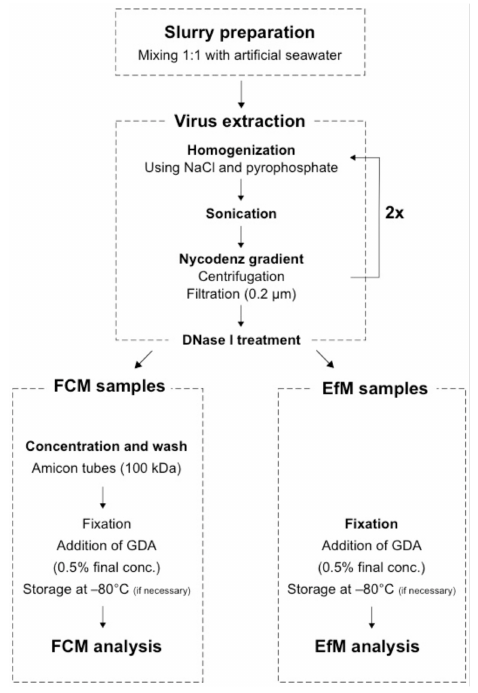
Figure 1. Schematic flow chart of the protocols for flow cytometric and epifluorescence microscopy enumeration. FCM: flow cytometry, EfM: epifluorescence microscopy, GDA: